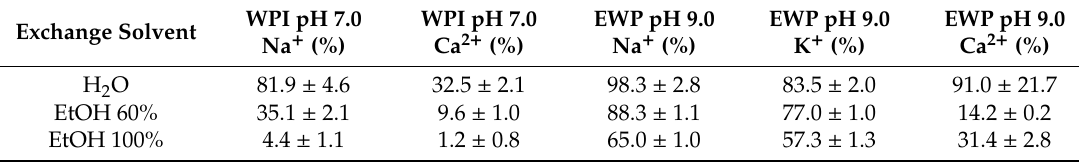
Table 1. Ions contained in exchange solution after 24 h of solvent